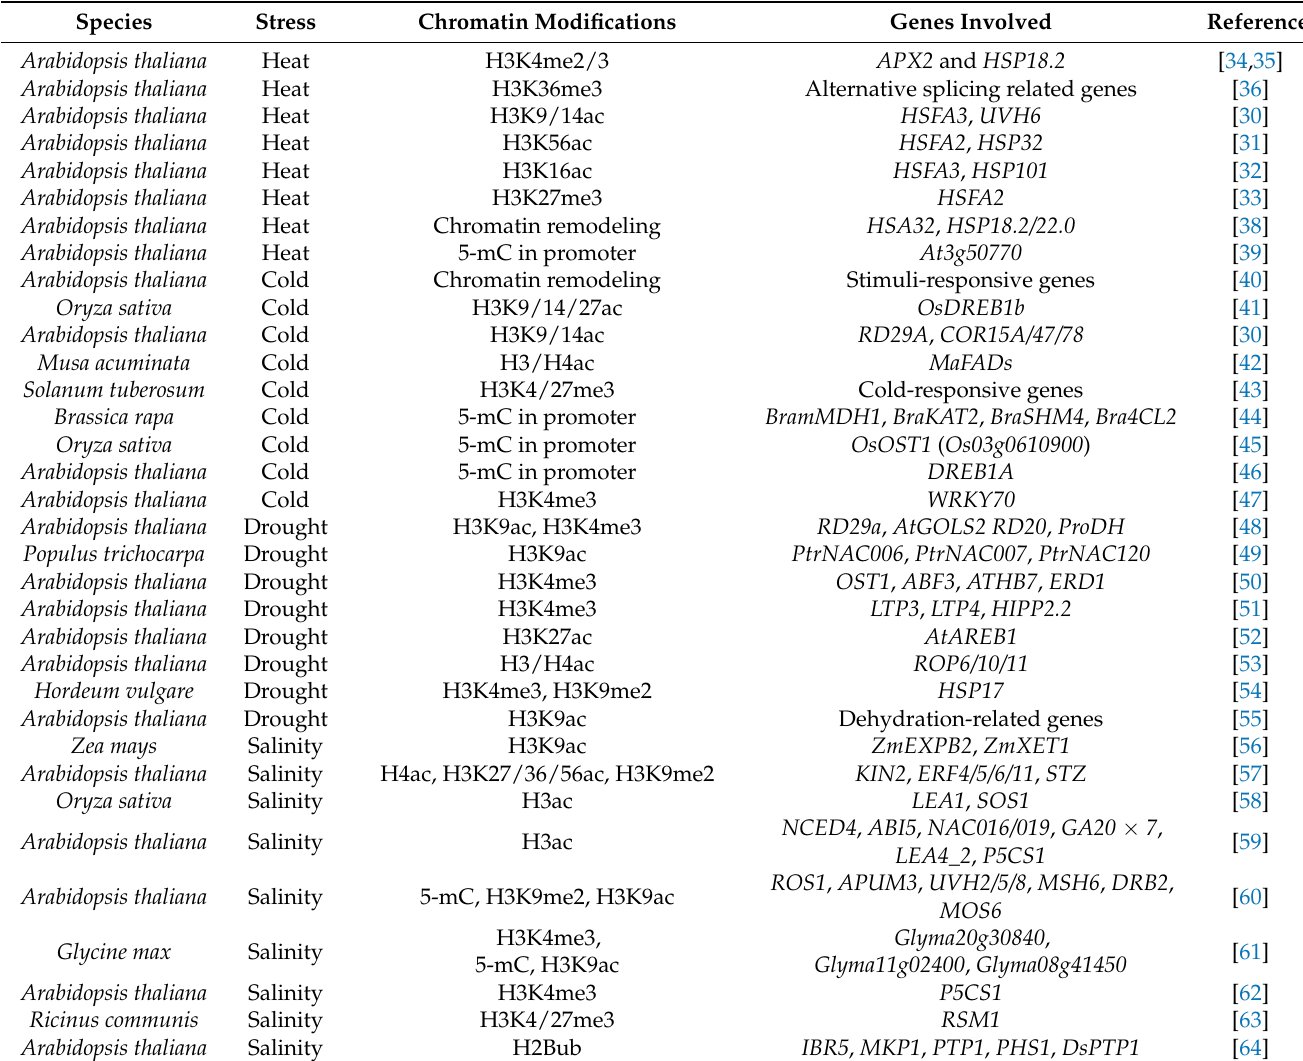
Table 2. Chromatin dynamics associated with abiotic stress conditions such as heat, cold, drought and salinity in